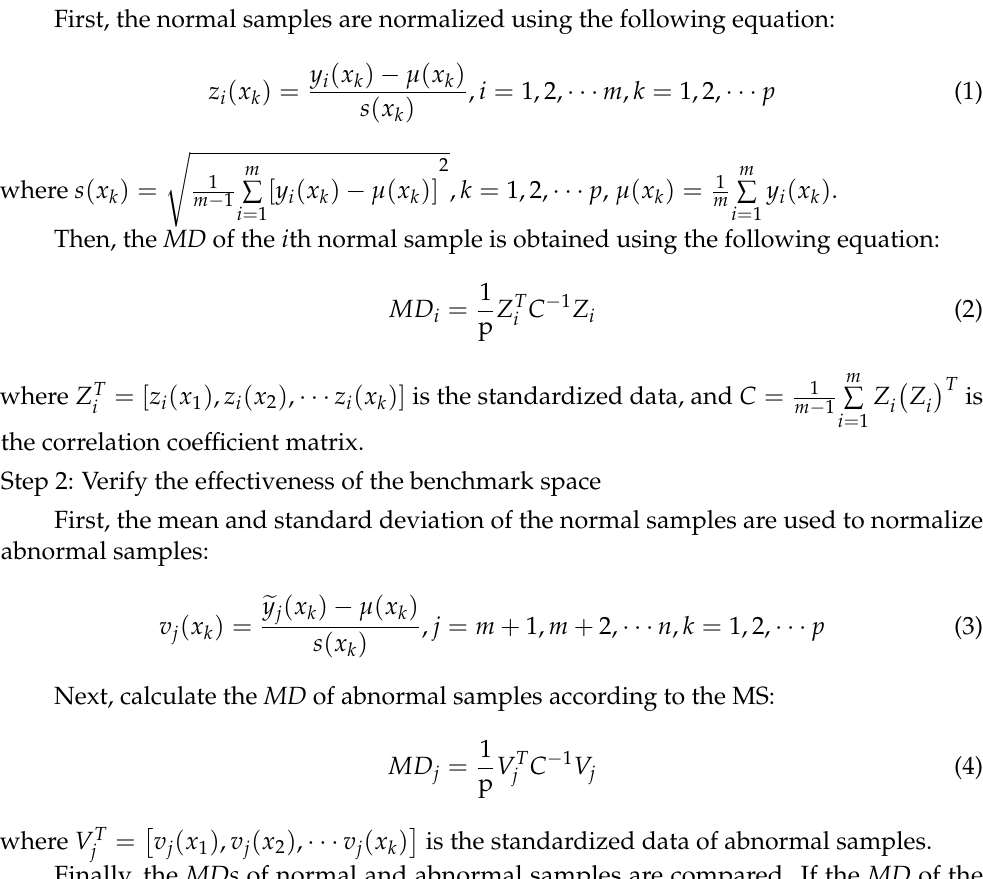
Figure 1. The measurement principle of